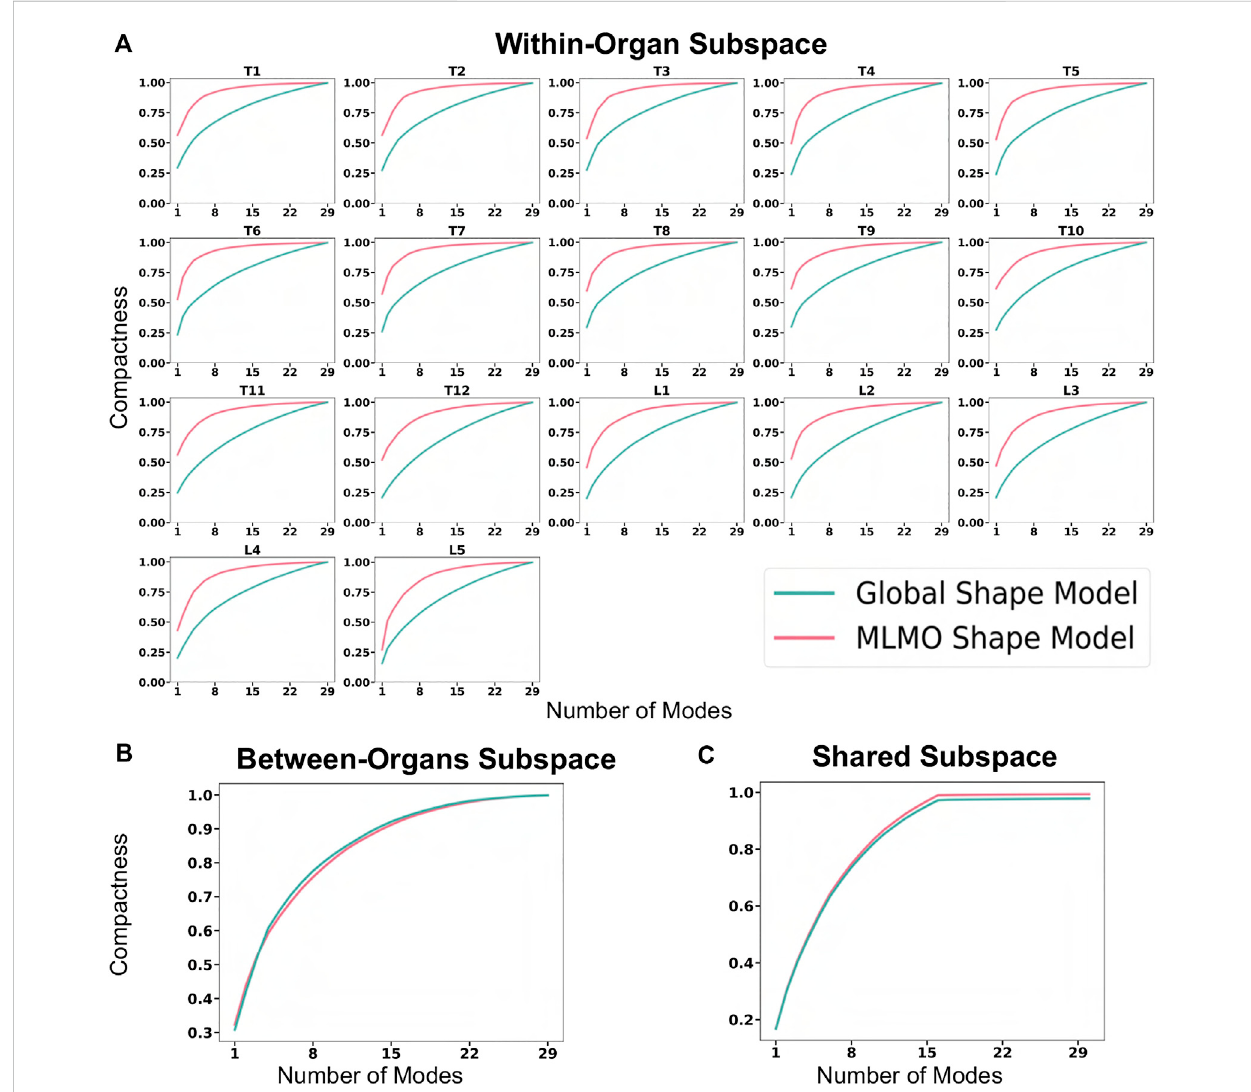
FIGURE 5 Compactness metric for spinal column data — (A) within-organ subspace. (B) Between-organs subspace. (C) Shared subspace.